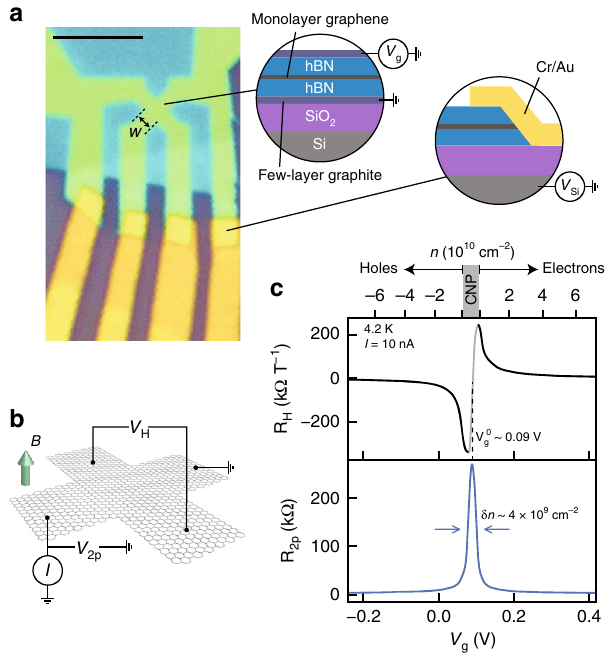
Fig. 2 Ultraclean graphene Hall sensors. a Optical microscope image of device G1 ( w = 1 µ m, scale bar: 5 µ m). Left cross-section: Hall cross layer structure consisting of monolayer graphene encapsulated with hexagonal boron nitride (hBN) and few-layer graphite. Right cross-section: edge contacts. b Schematic of the measurement con fi guration, with Hall voltage V V I , and out-of-plane magnetic fi eld B . H , two-point voltage 2p , bias current c Top gate voltage ( V g ) dependence of the Hall coef fi cient R H and two-point resistance R 2p at 4.2 K under small ac bias and background fi elds up to B = 100 mT. The upper axis indicates the corresponding electron and hole